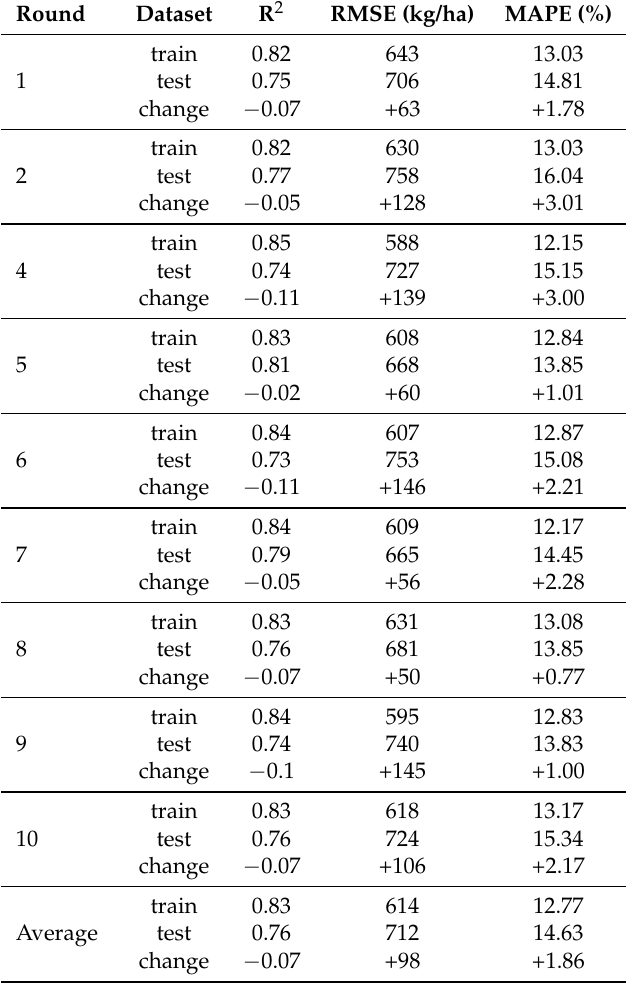
Table 3. Cross-validation of model with a random split from ten rounds. For each round, samples of 70% of the counties were used to train, the other samples were used to validate. Round Dataset R